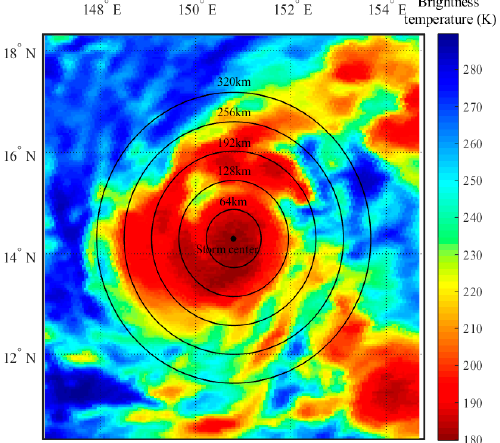
Figure 1. Schematic diagram for the definition of concentric annuli. The black filled circle is the center of the current TC. The large black circles spreading from the TC center to the outer are the annuli at the radii of 64 km, 128 km, 192 km, 256 km, and 320 km. Finer annuli are not shown here due to their poor visibility.